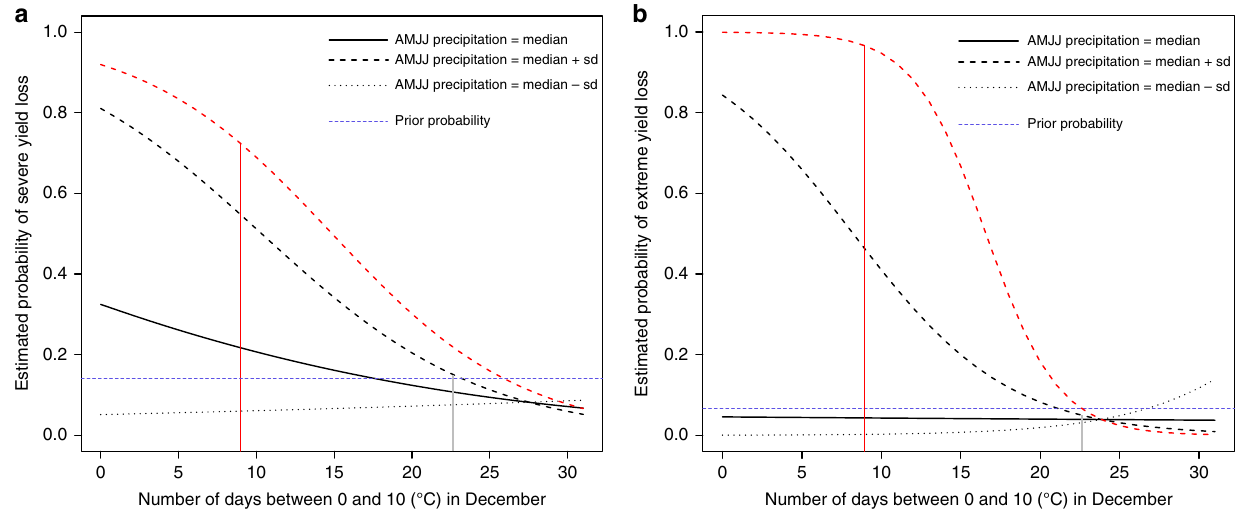
Fig. 4 Autumn – spring interaction. Modulation by spring precipitation of the relationship between the number of days between 0 and 10 °C in December and the probability of severe ( a ) and extreme wheat yield loss ( b ). Interactions are shown here for normal precipitation (daily AMJJ precipitation equal to the median over 1959 – 2016; bold line), and for wet and dry spring conditions (daily AMJJ precipitation equal to + / − one standard deviation; dotted lines). Vertical grey line: median number of days with maximum temperature between 0 and 10 °C over 1958 – 2016; red dotted lines: modeled value for 2016